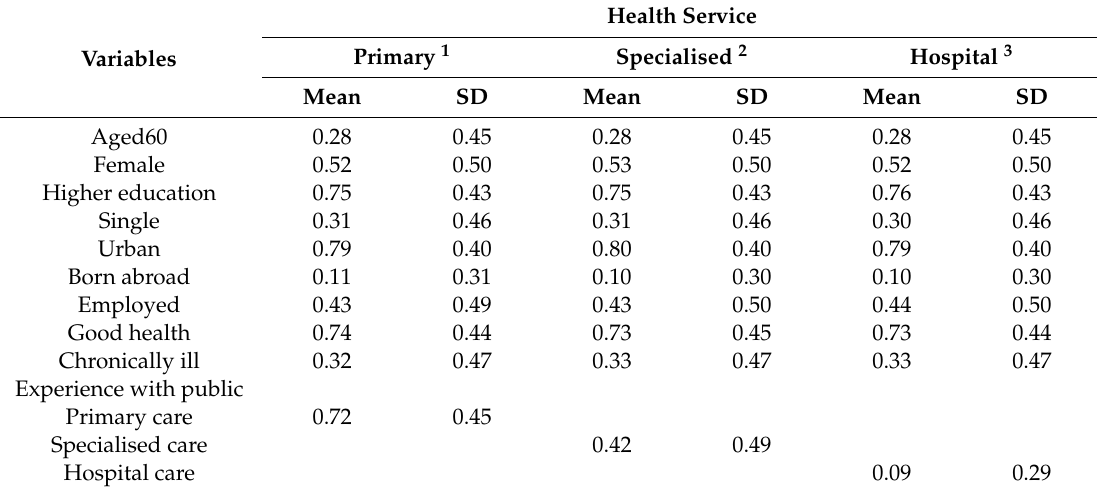
Table 5. Descriptive statistics of respondents’ socioeconomic characteristics,